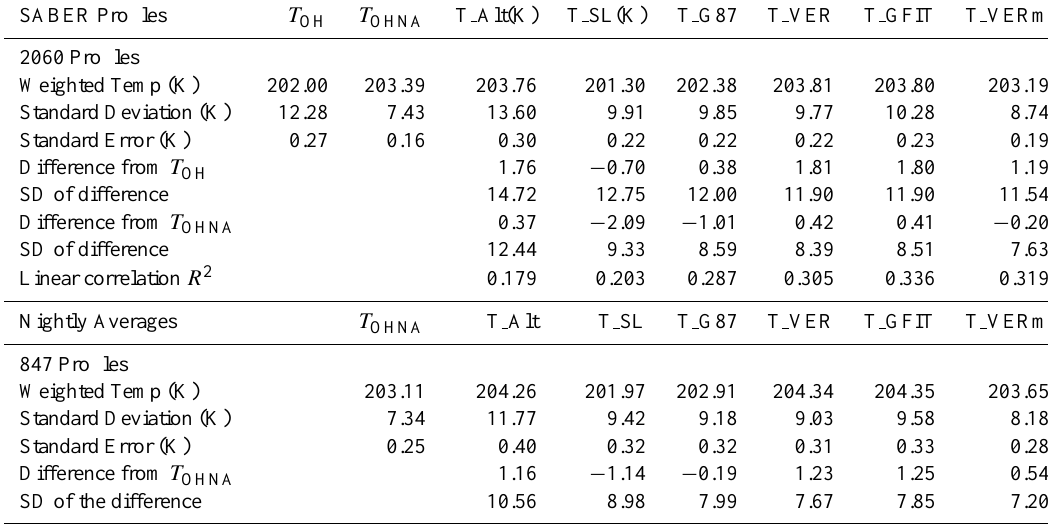
Table 1. A comparison of the mean temperatures and SABER-OH biases for each weighting profile for 2060 individual profiles and 847 nightly averages compared to the closest OH temperature measurement ( T OH ) and closest OH nightly average ( T OHNA )